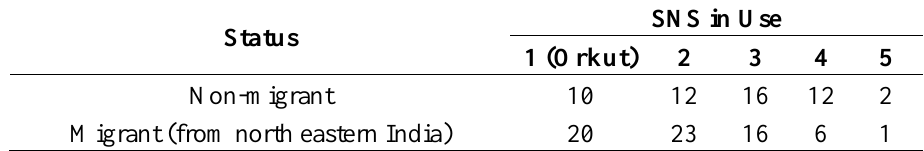
Table 1. Sample Composition, Study 1, by migrant status and number of SNS in use. SNS in Use Status 1 (Orkut) Non-migrant Migrant (from north eastern